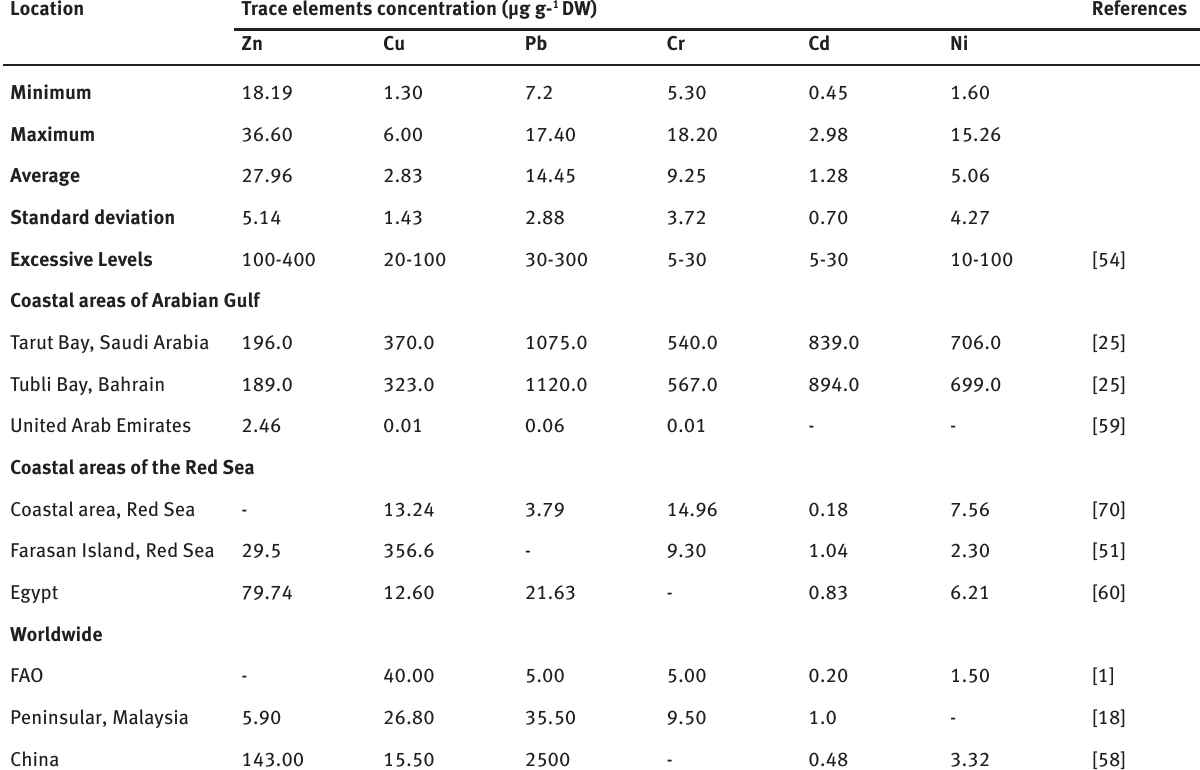
Table 4: Comparison of trace element contents (μg g -1 DW) in mangrove leaves with regional and around the world.